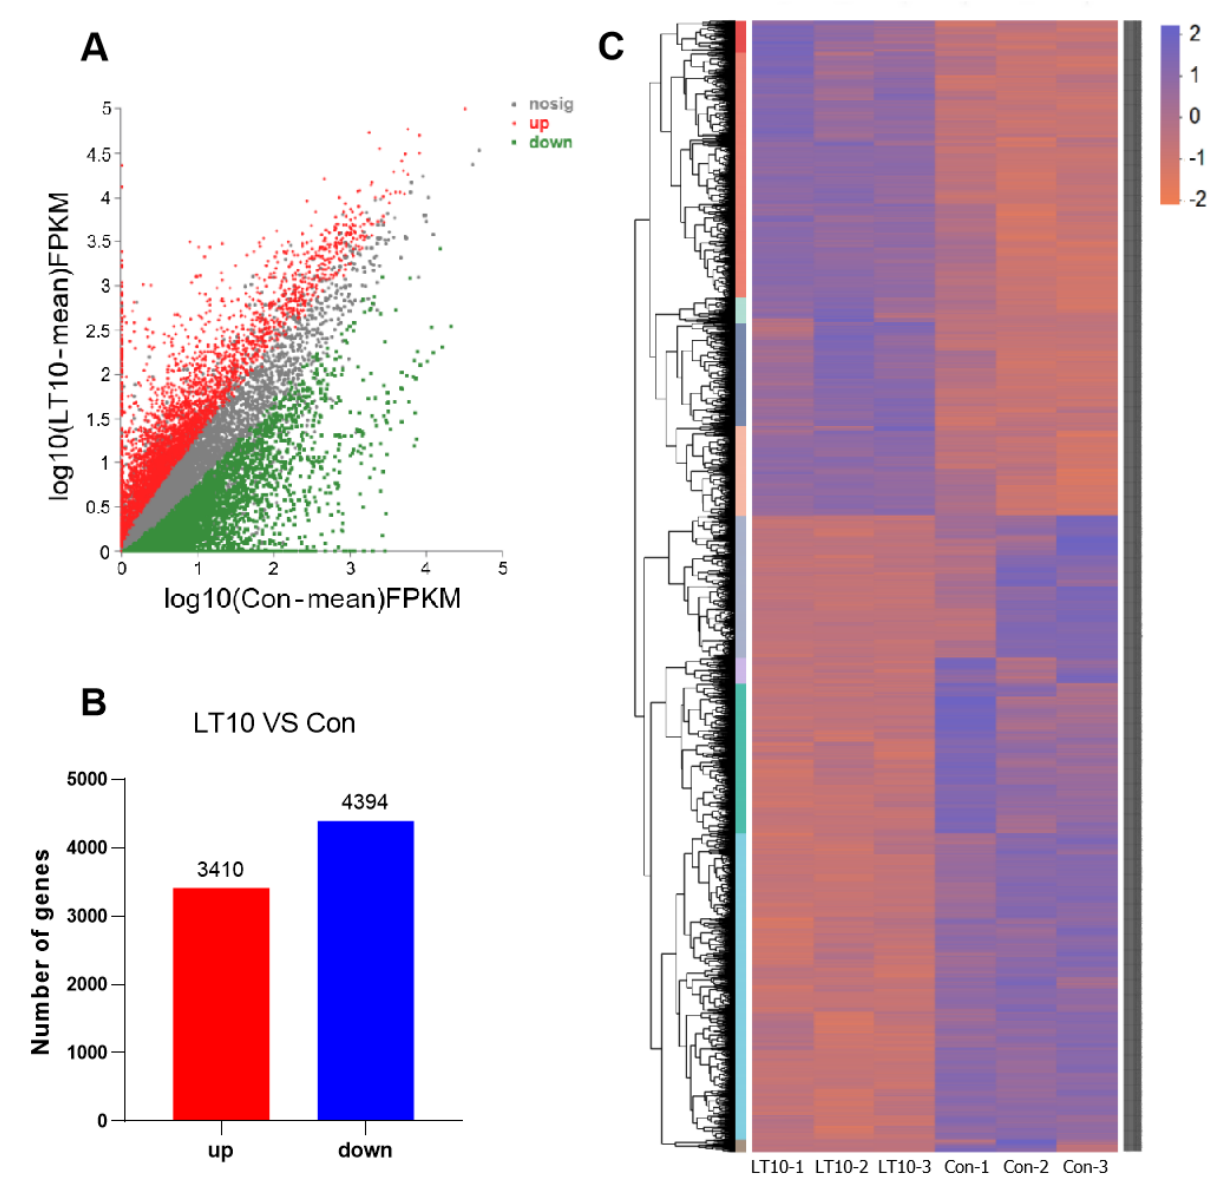
Figure 3. Transcriptome profile of freshwater drums liver induced by 2 days cold stress: ( A ) set diagram of DEGs; ( B ) up and down regulated DEGs; ( C ) heatmap of DEGs.